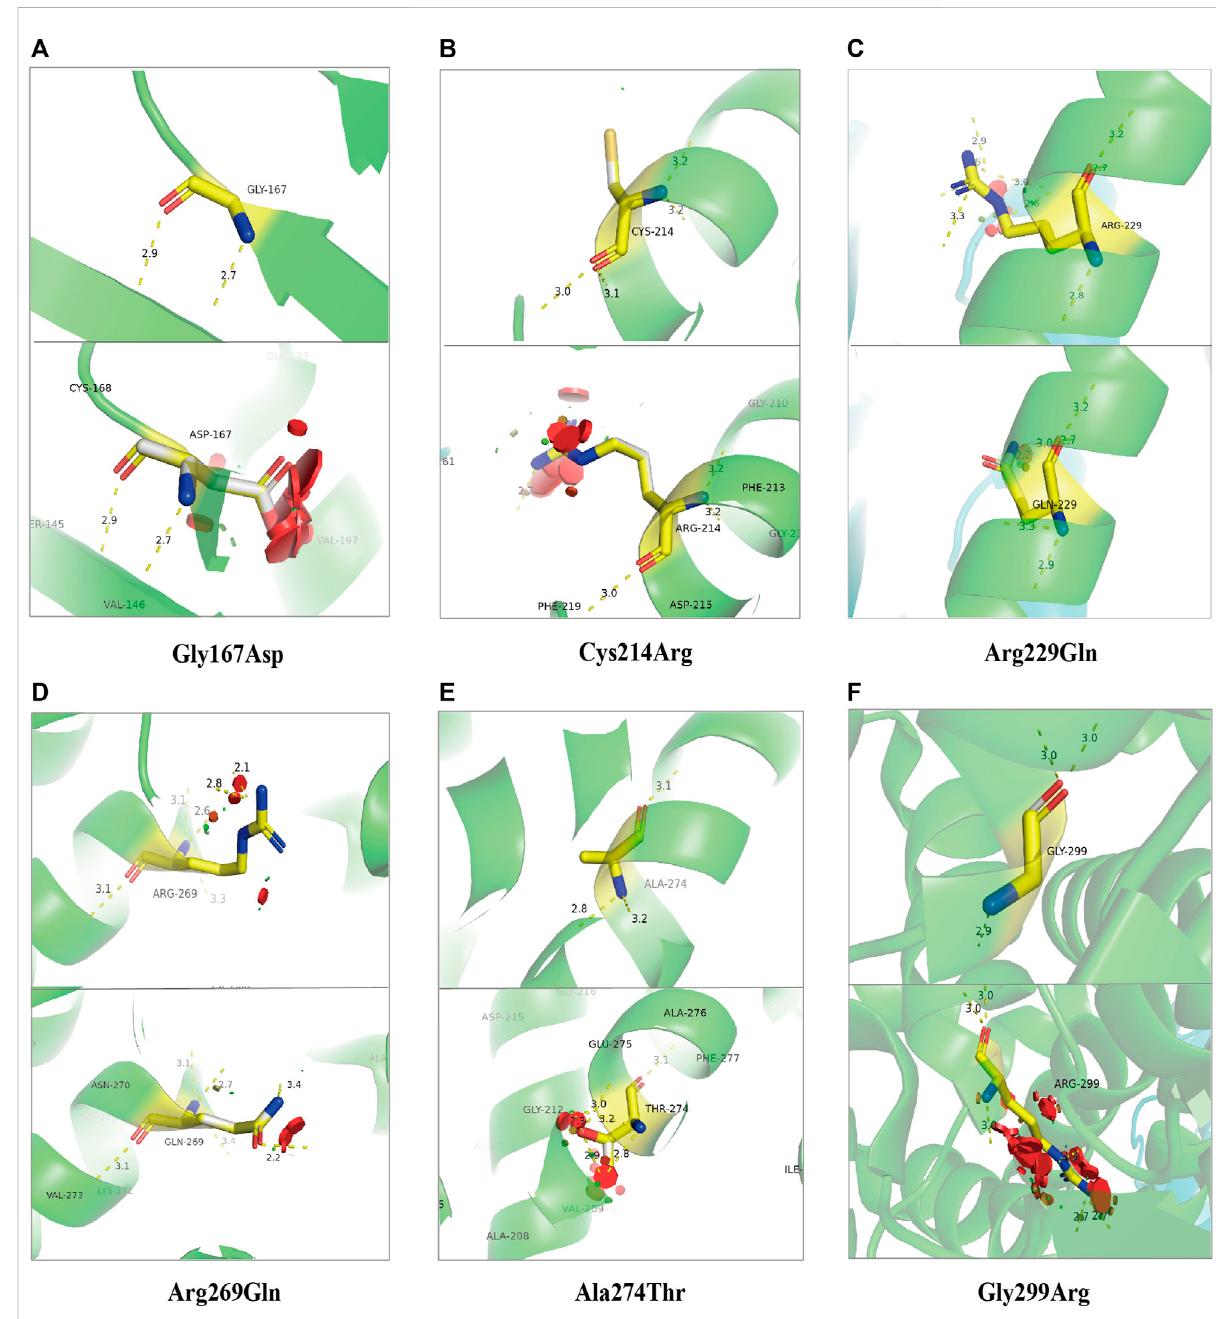
FIGURE 7 Stimulationdiagramofaminoacid/proteinthree-dimensionalstructurechangescausedbymissensevariantsof GPD1 gene.Theyexistinthe β - folding [ (A) . Gly167Asp],helical bundle[ (B) .Cys214Argand (E) .Ala274Thr],thedimerbinding surface[ (C) . Arg229Gln], active site[ (D) .Arg269Gln and (F) . Gly299Arg].We cansee these tertiary structuralchangesin thespatial strcture ofamino acid disability before and after missense variants atthese sites. This picture was drawn using PyMOL